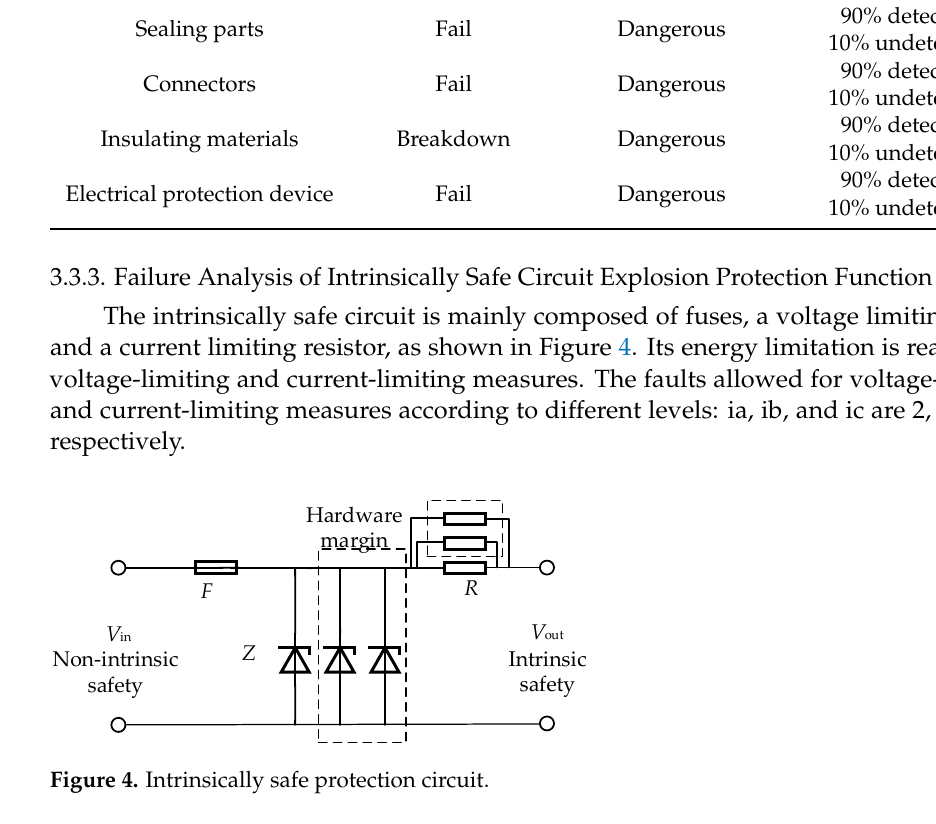
Table 3. Failure mode of flameproof enclosure.